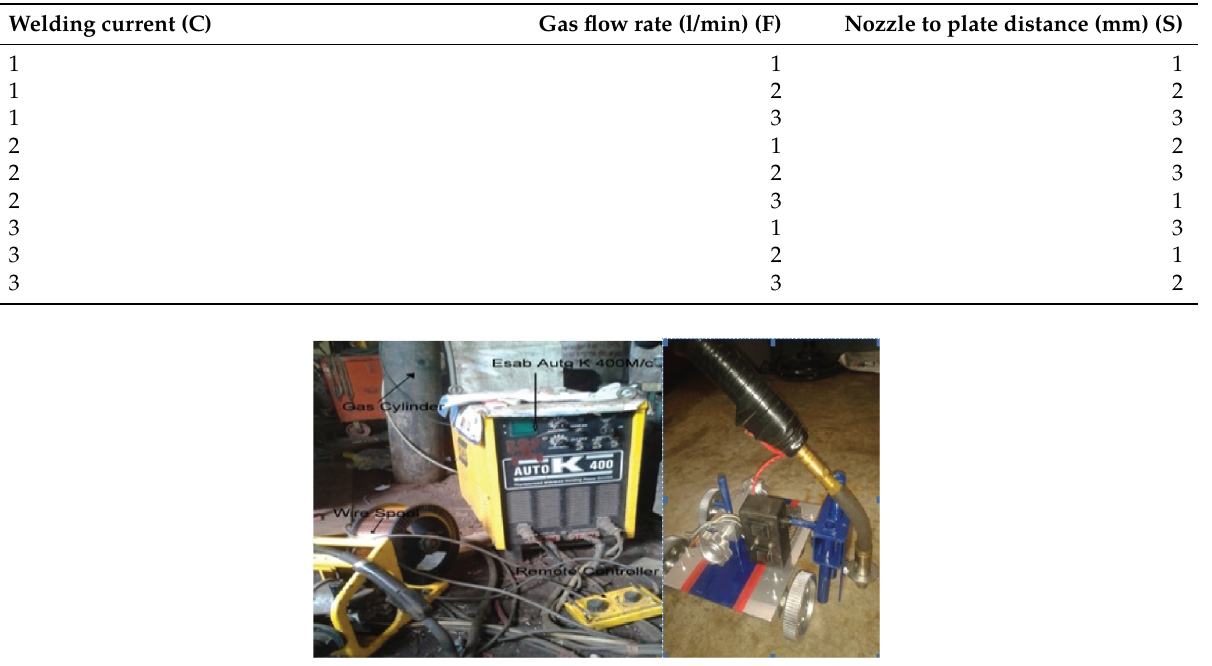
Table 2: Welding design matrix as per L9 Taguchi orthogonal array design of matrix.